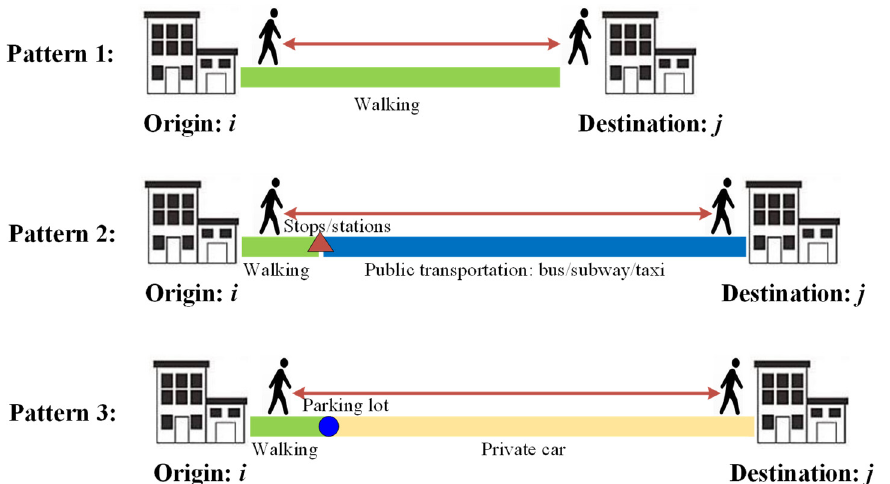
Figure 2. Three travel patterns of residents when they come out from their home to reach their des-